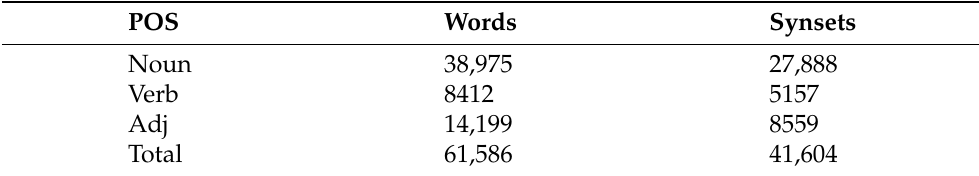
Table 1. An overview of the words and synsets of nouns, verbs, and adjectives in Chinese Open WordNet. POS